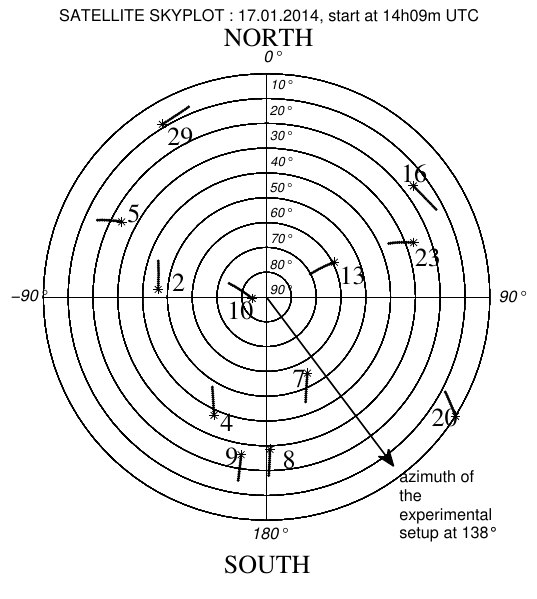
Figure 12. Trajectories of the satellites in view during the measurements, on 17 January 2014, at 14h09 UTC.